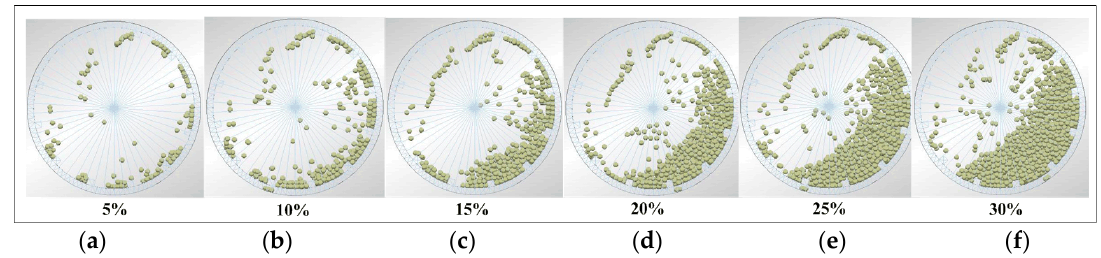
Figure 8. Photograph of the impact load behavior with 75% critical speed at 5%–30% grinding media filling: ( a ) 5%; ( b ) 10%; ( c ) 15%; ( d ) 20%; ( e ) 25%; and ( f ) 30%.